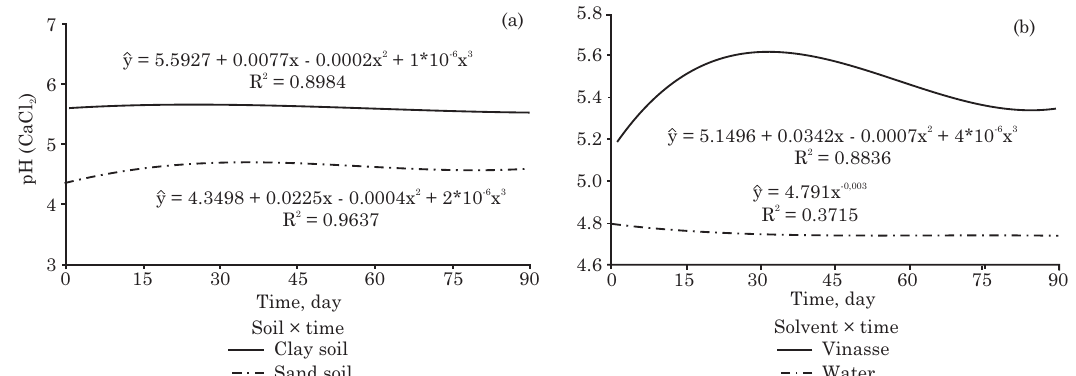
Figure 4. Levels of pH in CaCl 2 based on time, soil type (Red Oxisol - clayey soil and Typic Quartzipsamment - sandy soil) and vinasse application: (a) Soil × time interaction; (b) Solvent × time interaction.